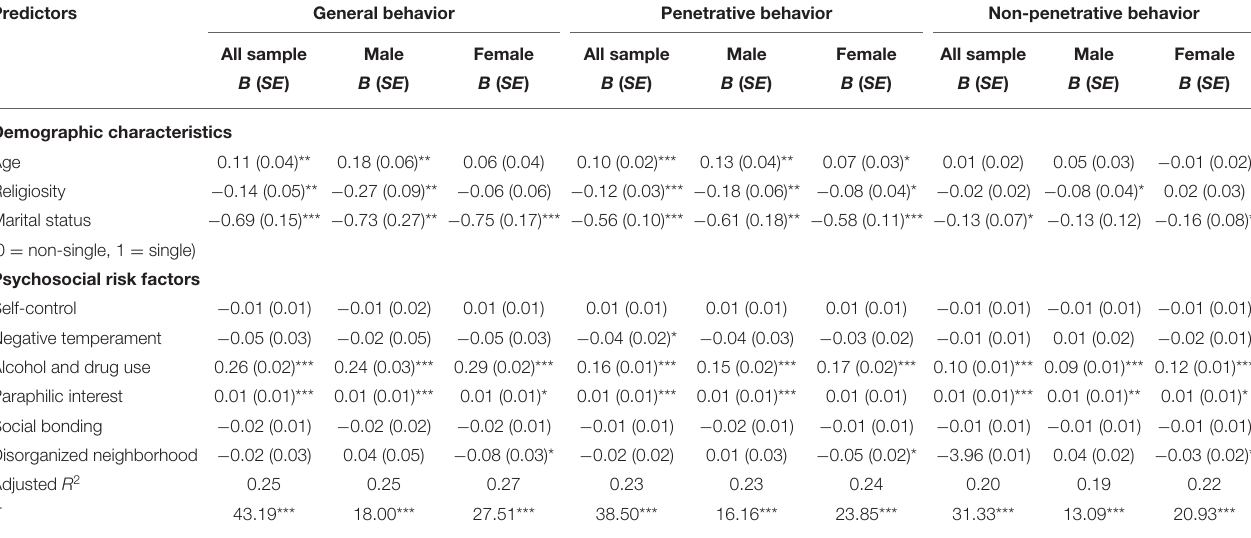
TABLE 4 | OLS regression models of self-reported risky sexual behavior.